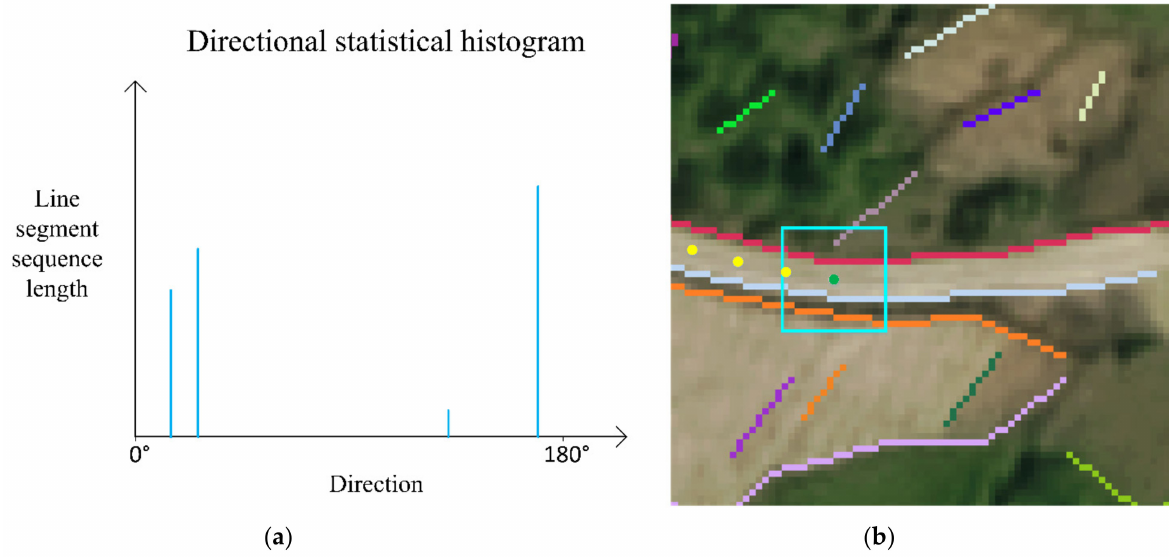
Figure 5. Tracking direction prediction model. ( a ) Direction distribution statistics of line segment sequence. ( b ) Line segment sequence detected by the current centre